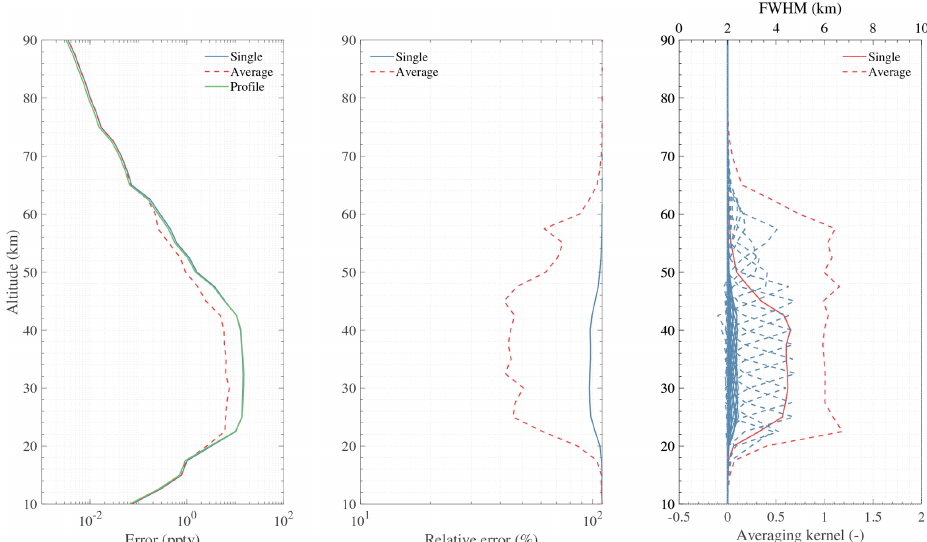
Figure 23. Simulation results of BrO retrieval using 624.768GHz lines. “Single” and “Average” represent the retrieval error using different noise. “Profile” represents the typical profile used in the simulation. The black solid line in the last panel represents the FWHM (i.e. vertical